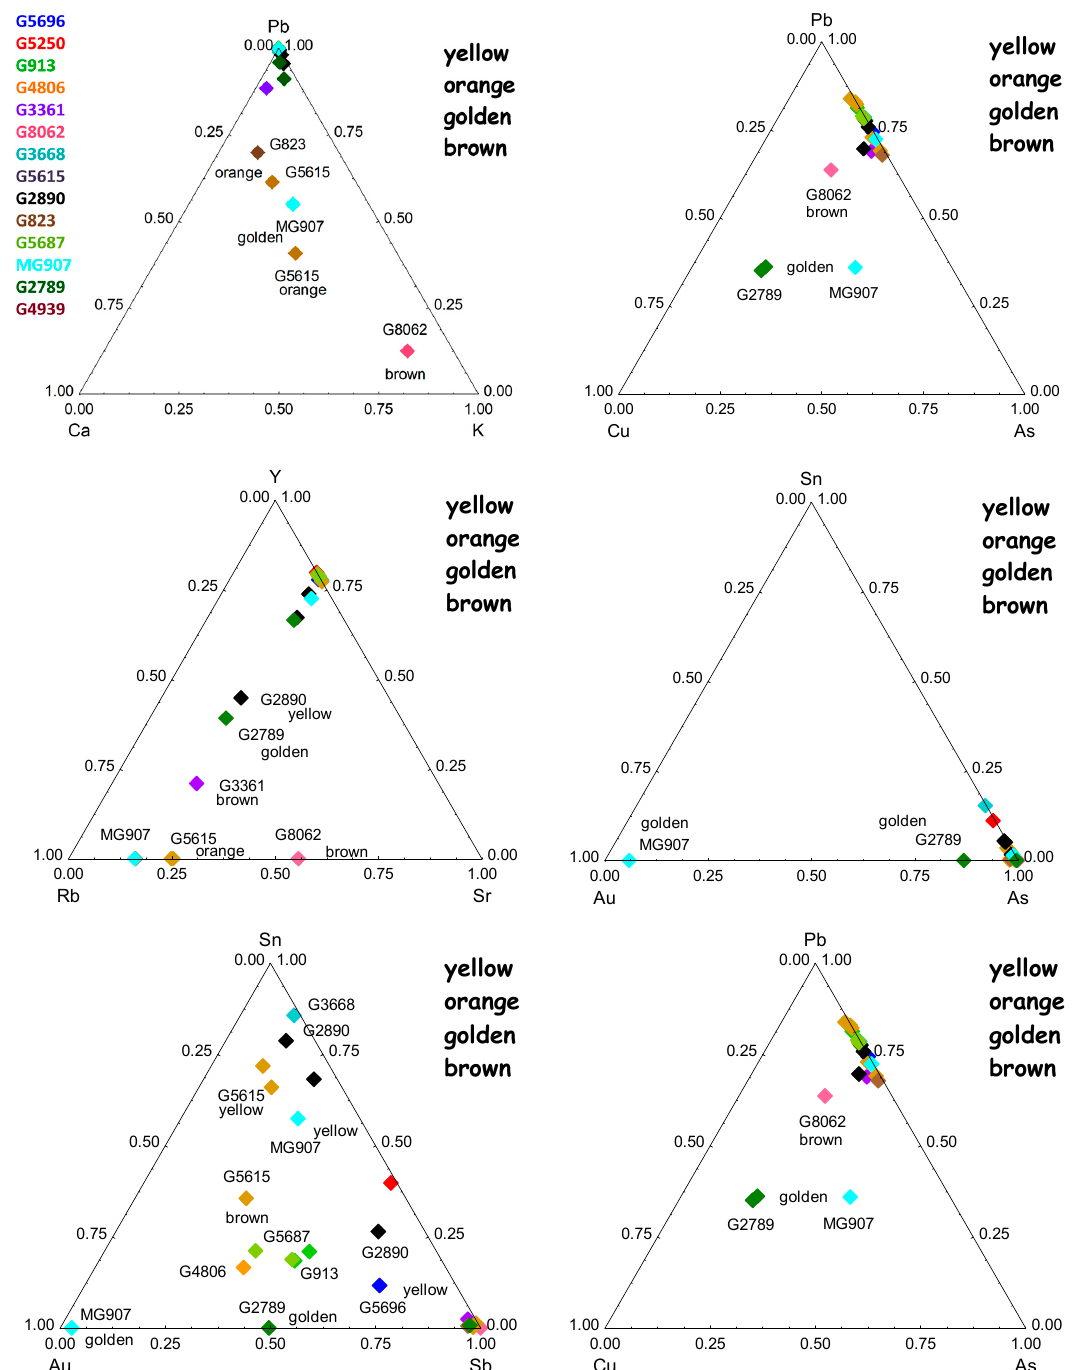
Figure 8. Comparison of signal of elements associated with the colors yellow, orange, brown and gold. See legend to Figure 5 for explanation of symbols.